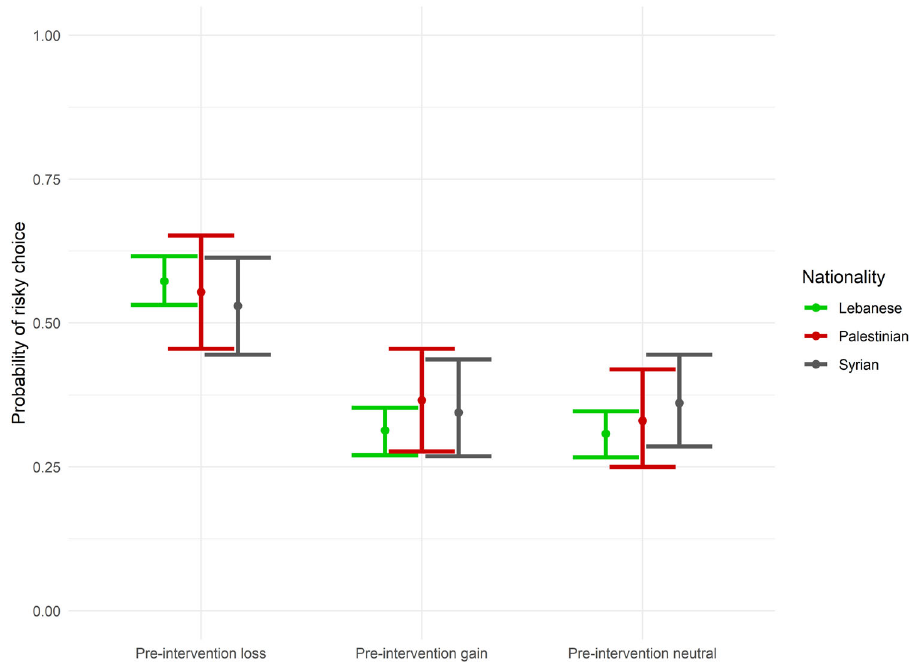
Fig. 5 Risky choice proportion at baseline. For all three populations, the probability of risky choice was higher in the group where the pre-intervention item was